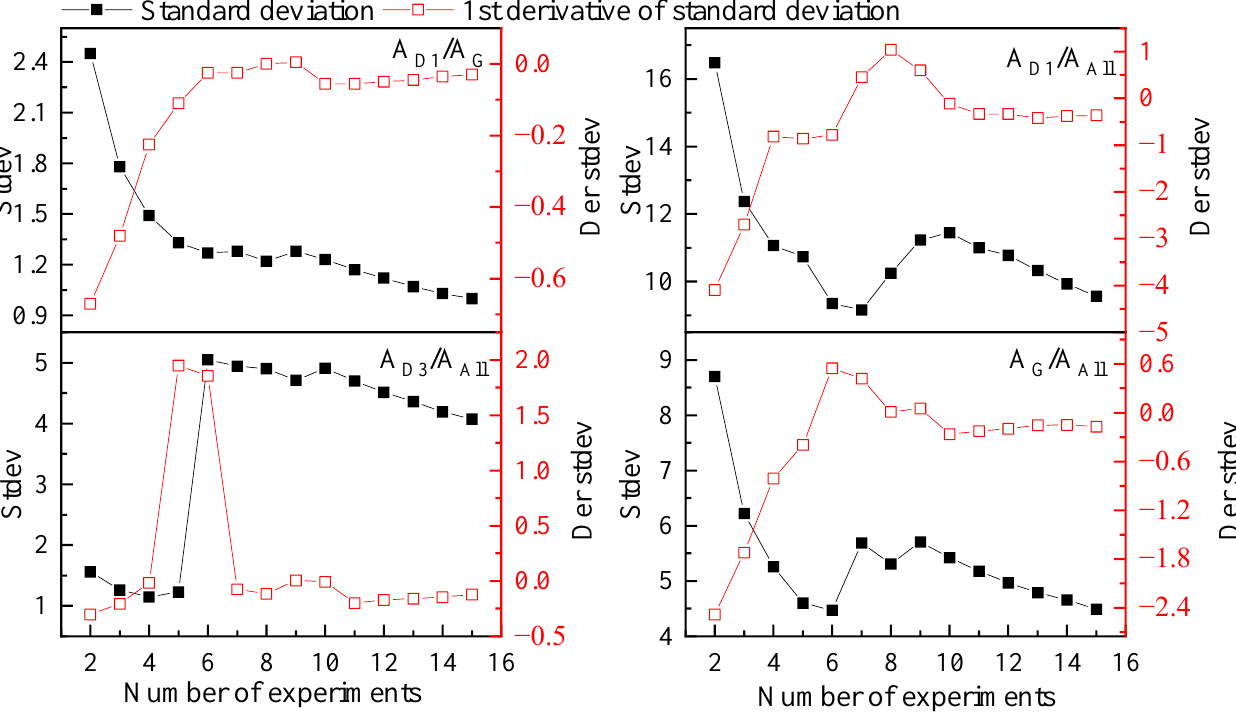
Figure 7. Standard deviations and corresponding derivatives of char1 Raman characteristic param- eters.